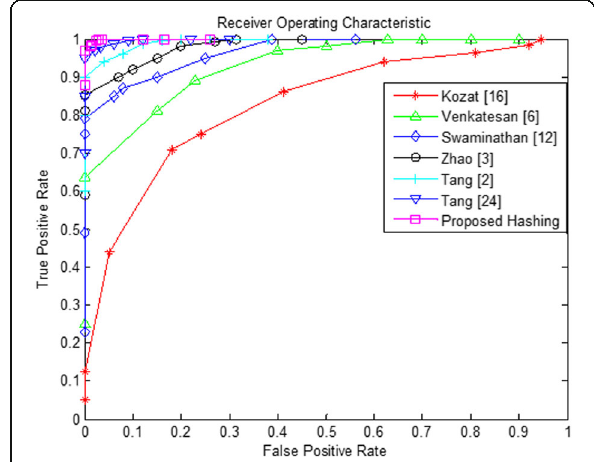
Fig. 14 Receiver operating characteristic for performance